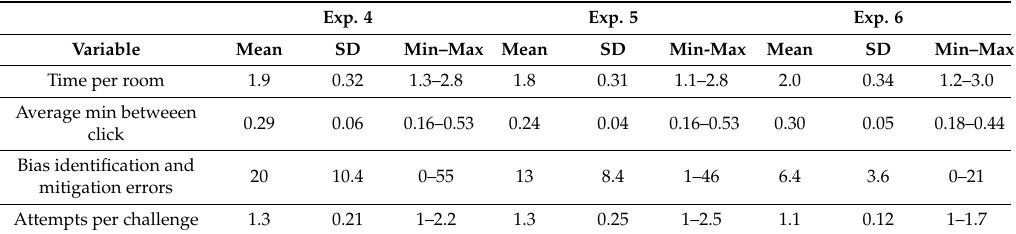
Table 2. Descriptive statistics for CYCLES Carnivale difficulty